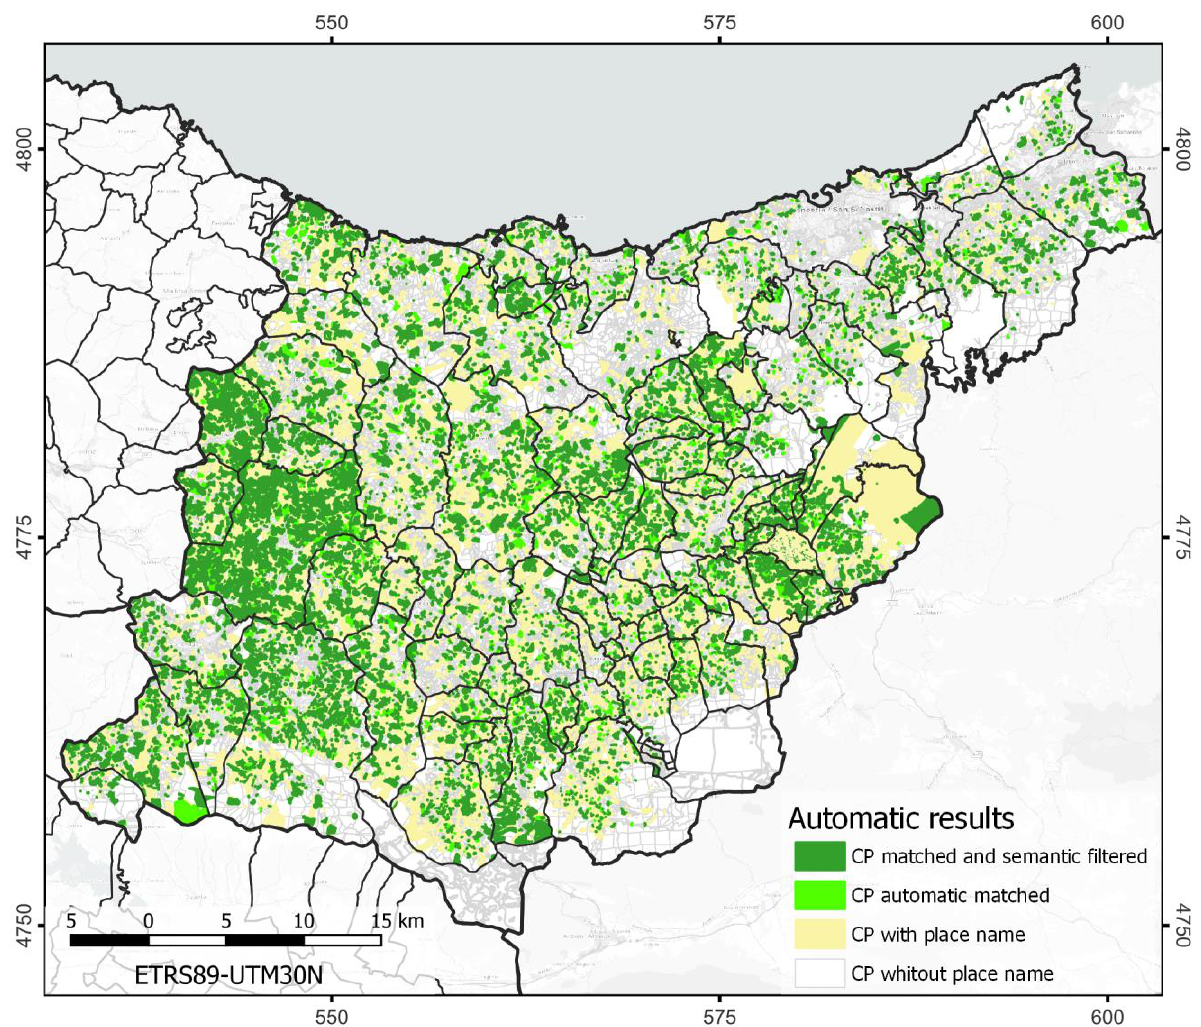
Figure 9. Results from the proposed method to the whole province of Gipuzkoa. Frame coordinates in km.